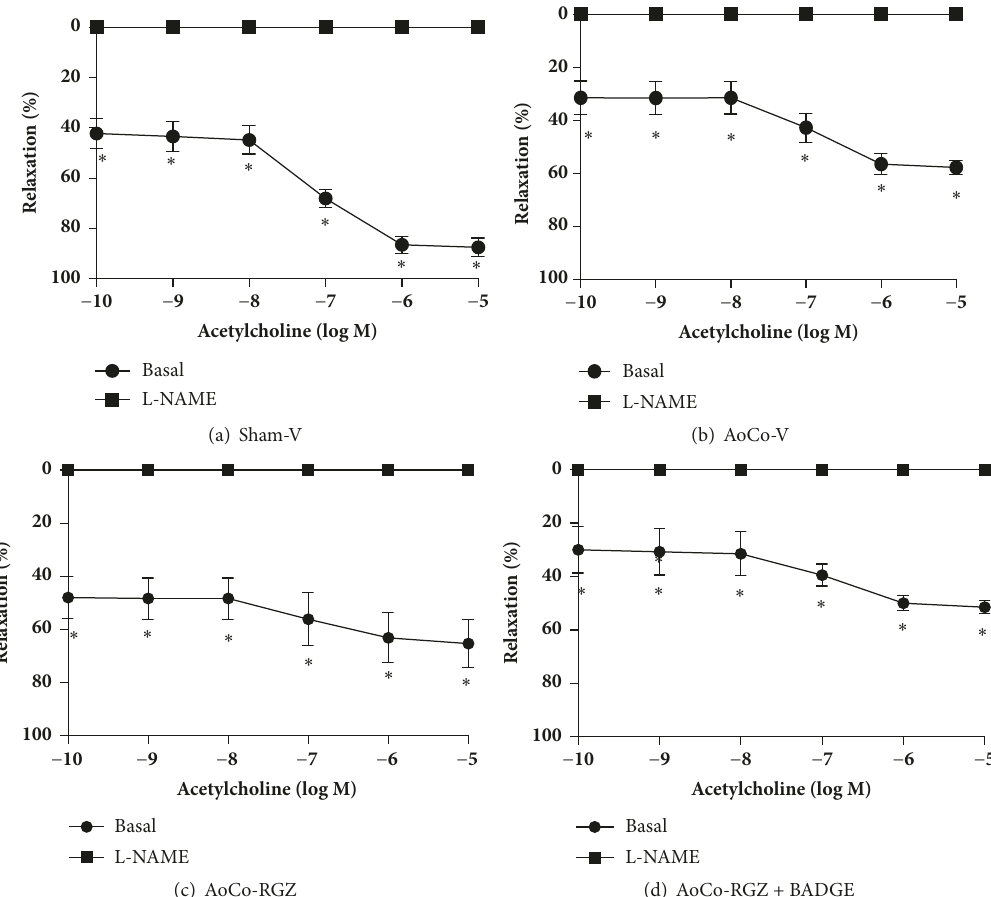
Figure 2: Effect of rosiglitazone (RGZ) on vascular reactivity exerted by acethylcholine. The aortic reactivity was evaluated in sham-vehicle treated (a), aortic coarctated (AoCo)-vehicle treated (b), AoCo-RGZ treated (c), and AoCo-RGZ + bisphenol A diglycidyl ether (BADGE) treated(d) ratsunder basal conditions ( e ) or in presenceof N( 𝜔 )-nitro-L-arginine-methyl-ester(L-NAME, 300 𝜇 M)( ◼ ). Thevalues represent the mean ± SEM (n=6 animals per group). One-way analysis of variance (ANOVA) post Tukey. ∗ P < 0.05 basal vs. L-NAME